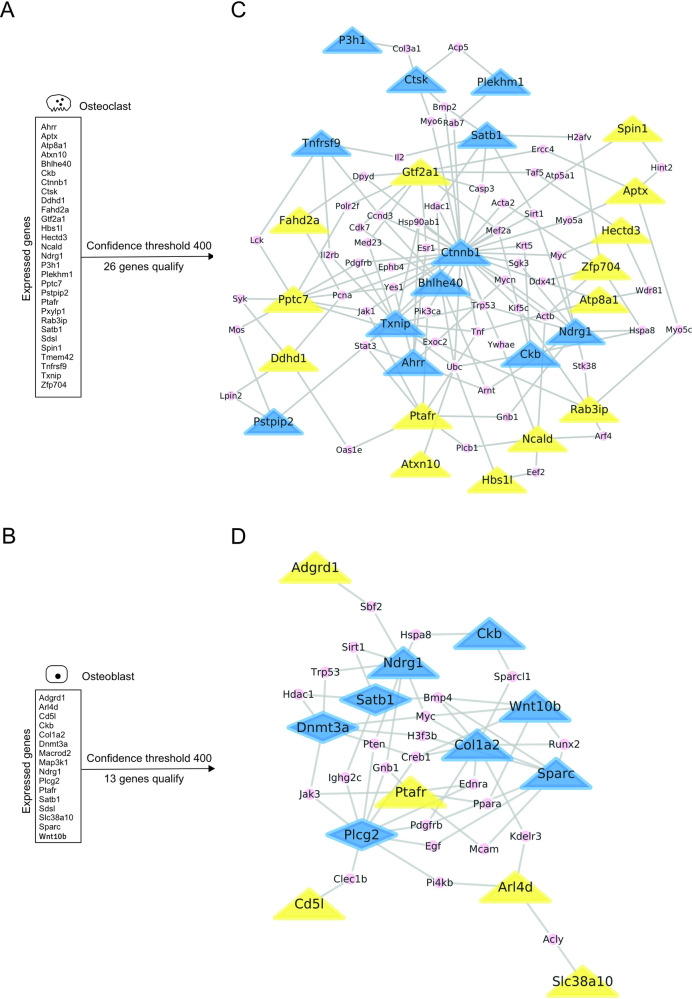
Subsets of BMD proteins mapped specific pathways in osteoclasts and osteoblasts.Using curated NCBI Gene Expression Omnibus data, expression of the 200 BMD genes was mapped in (A) osteoclasts, the bone resorbing cells, and (B) osteoblasts, the bone-forming cells. Protein-protein interactions (PPIs) were identified using the STRING database allowing the annotation of 178 of the 200 BMD genes. The central hubs of the network where identified based on the betweenness centrality index and extracted from the main network. All PPIs were presented as black lines. Blue and yellow nodes represent class 1 (known function in bone biology) and class 2 genes (unknown function in bone biology), respectively. The zygosity of the mutants is indicated by a triangular (homozygous) or diamond (heterozygous) shape of the node. The resulting central protein-protein interactions sub-networks in osteoclasts (C) and osteoblasts (D) are shown. Proteins connecting the BMD gene nodes were represented as small pink nodes.